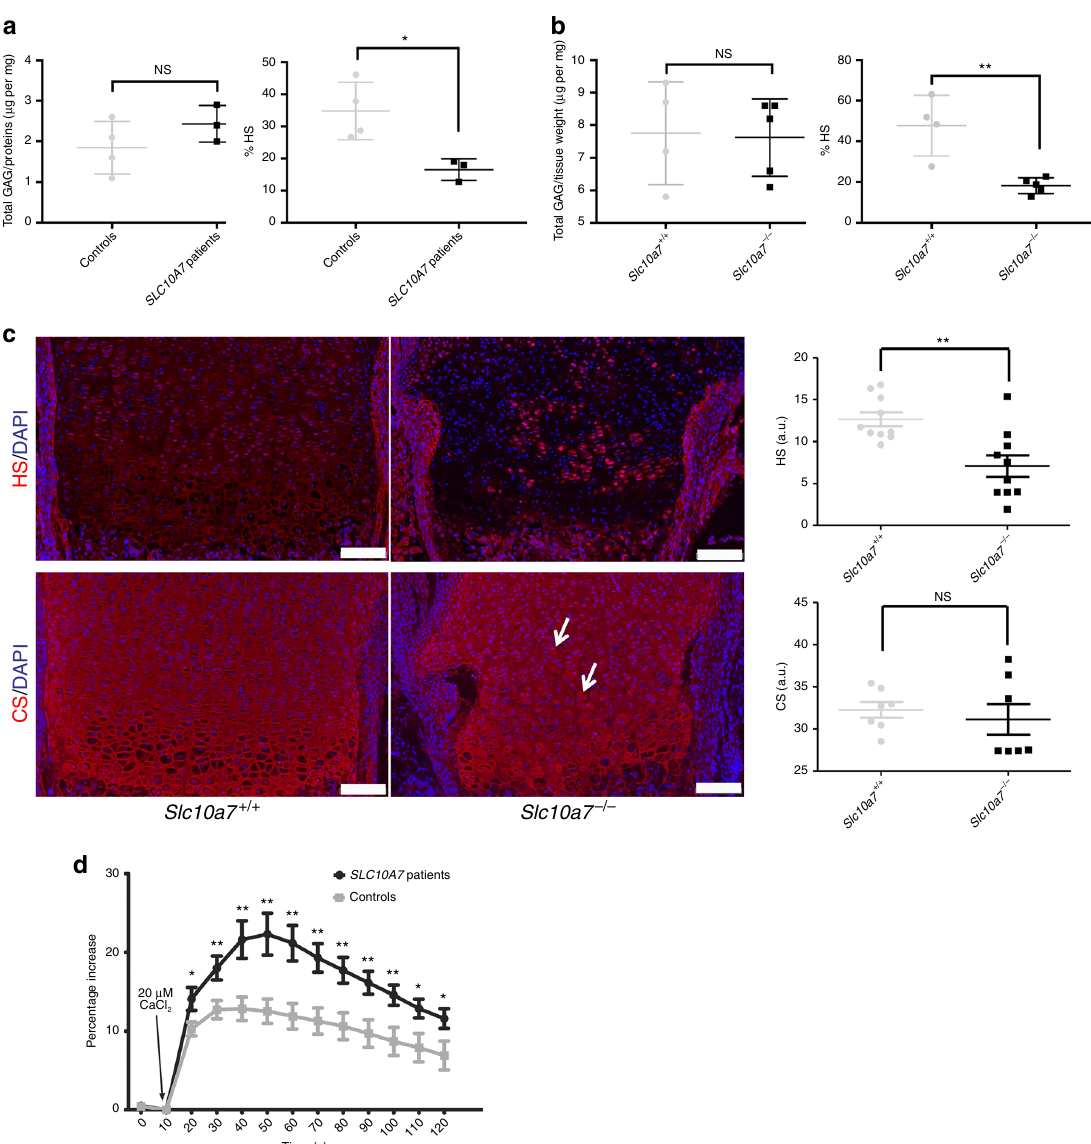
Fig. 6 SLC10A7 de fi ciency leads to defective GAG and enhanced Ca 2 + intake. a , b Total sulfated GAGs and heparan sulfates (HS) were quanti fi ed according to the DMMB procedure in extracts of SLC10A7 -de fi cient patient fi broblasts and control fi broblasts ( n = 3) ( a ) or in cartilage extracts from 10-day-old Slc10a7 − / − or Slc10a7 + / + mice ( n = 5) ( b ). Proportions of HS are expressed as a percentage of total sulfated GAGs (% HS). c Immunohisto fl uorescence for HS (red) or CS (red) counterstained with DAPI (blue) on distal femurs of newborn Slc10a7 + / + and Slc10a7 − / − mice ( n = 5 mice). Arrows indicate more intense CS staining at the close proximity of chondrocytes. Scale bars = 100 μ m. Graphs show red fl uorescent signal intensity in the growth plate for each marker. a.u., arbitrary unit. Data are expressed as mean ± SD. NS, nonsigni fi cant; ** p ≤ 0.01 (two-tailed t- test). d A representative recording of intracellular free Ca 2 + in SLC10A7 -de fi cient patients fi broblasts and control fi broblasts ( n = 3). Fibroblasts were loaded with Fluo-4-AM and preincubated in calcium- free buffer for 30 min before addition of 20 μ M CaCl 2 . Data are presented as mean ± SEM, * p ≤ 0.05; ** p ≤ 0.0.1 (two-tailed t-